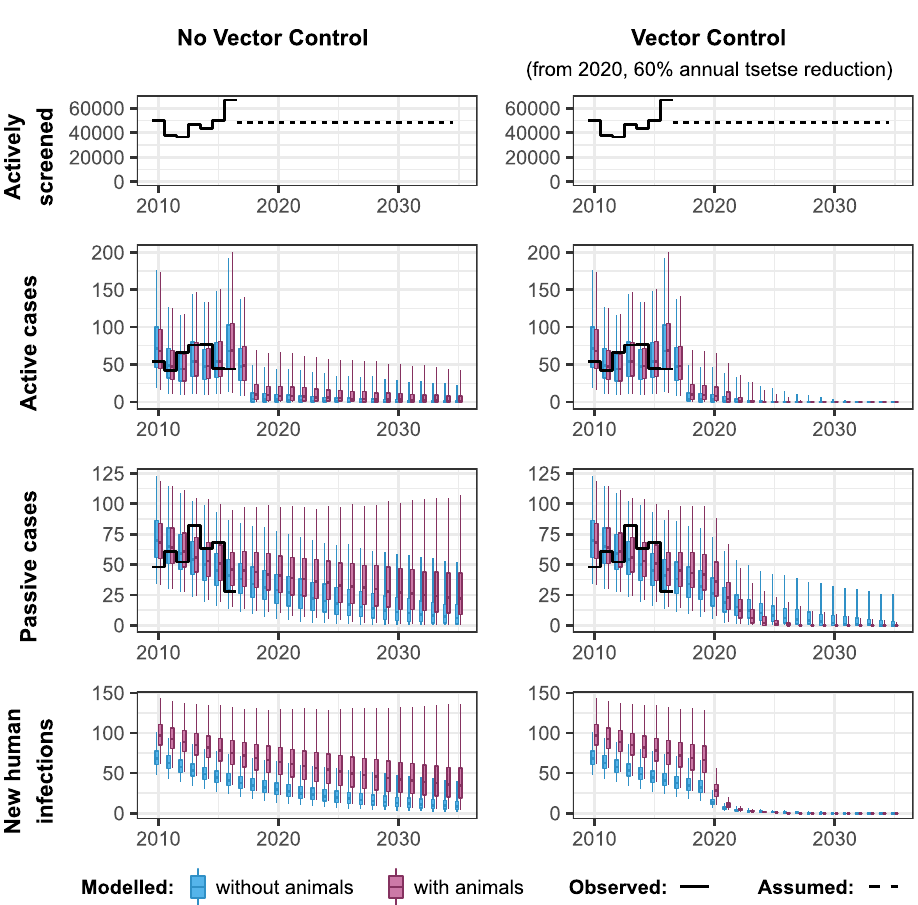
Fig 7. Forward projections in Bokoro health zone for models with and without animals contributing to gHAT transmission and with or without Tiny Target-based vector control (VC) from 2020. Future active screening (AS) is assumed to be at the average level of screenings from 2012–2016. In Bokoro, and other health zones in the former province of Bandundu, the specificity of AS was assumed to increase to 100% in 2018 due to video confirmation.